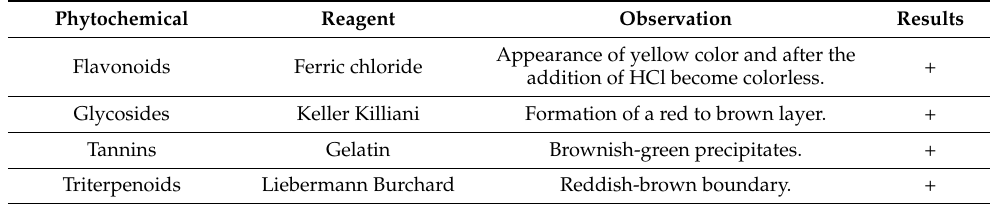
Table 1. Preliminary qualitative phytochemical screening of Indigofera linifolia crude extract.